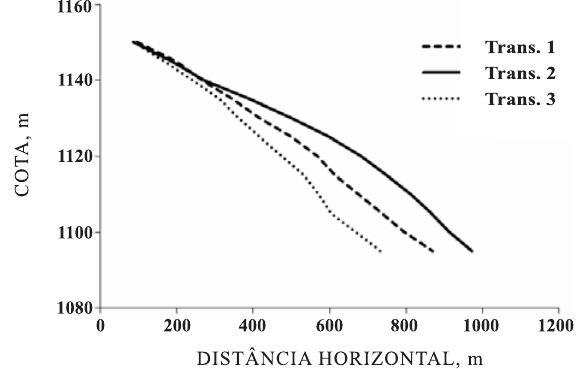
Figura 2. Perfis topográficos dos três transectos da vertente usados no estudo.